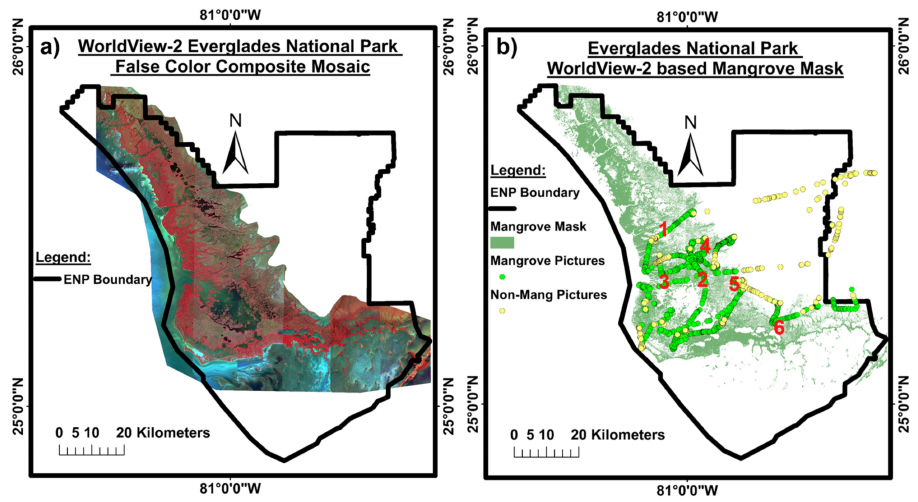
Figure 3. ( a ) WorldView-2 imagery (7 scenes) used to classify mangrove cover. Mangrove cover shows a bright red spectral signature, mostly located at the Western and Southwestern areas of the map; ( b ) Mangrove cover mask created with WorldView-2 and validation points obtained from high-resolution geo-tagged airborne photography. Red numbers show the locations of photos shown in Figure 4.